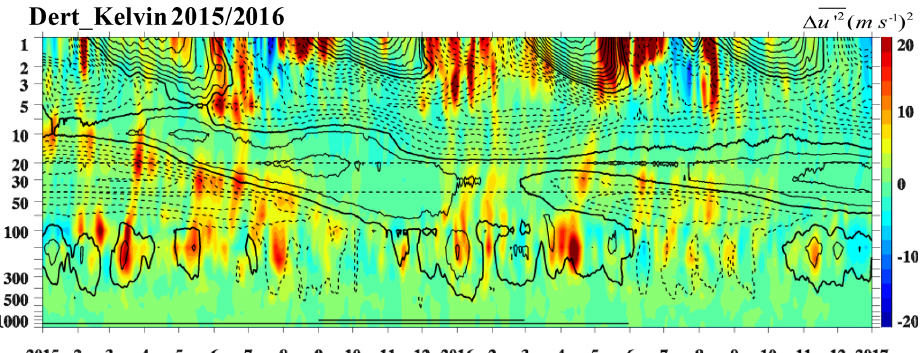
Figure 13. Temporal evolution of Kelvin wave activity as squared zonal wind anomalies averaged over 10 ◦ S–10 ◦ N in the vertical direction. Color shading denotes the anomalies with respect to the monthly climatology (0m 2 s − 2 ). The horizontal dashed lines denote the altitudes of 20 and 40hPa. The zonal mean zonal wind is overlaid in black contours with contour interval of 5ms − 1 . The solid and dotted black contours denote westerly and easterly winds, respectively. The thick contours represent the zero wind line. The horizontal solid lines denote the El Niño (single line) and strong El Niño periods (double line) in the bottom.